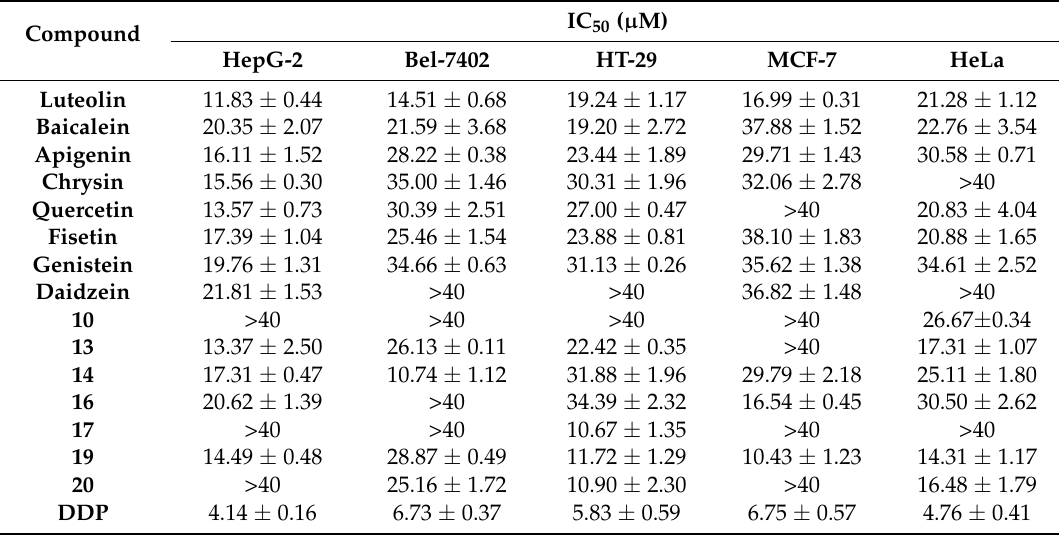
Table 3. IC 50 values of TMP-flavonoid derivatives and raw materials on HepG-2, Bel-7402, HT-29, MCF-7 and HeLa for 72 h. Data were expressed as inhibitory ratio ± SD based on three independent experiments ( n =